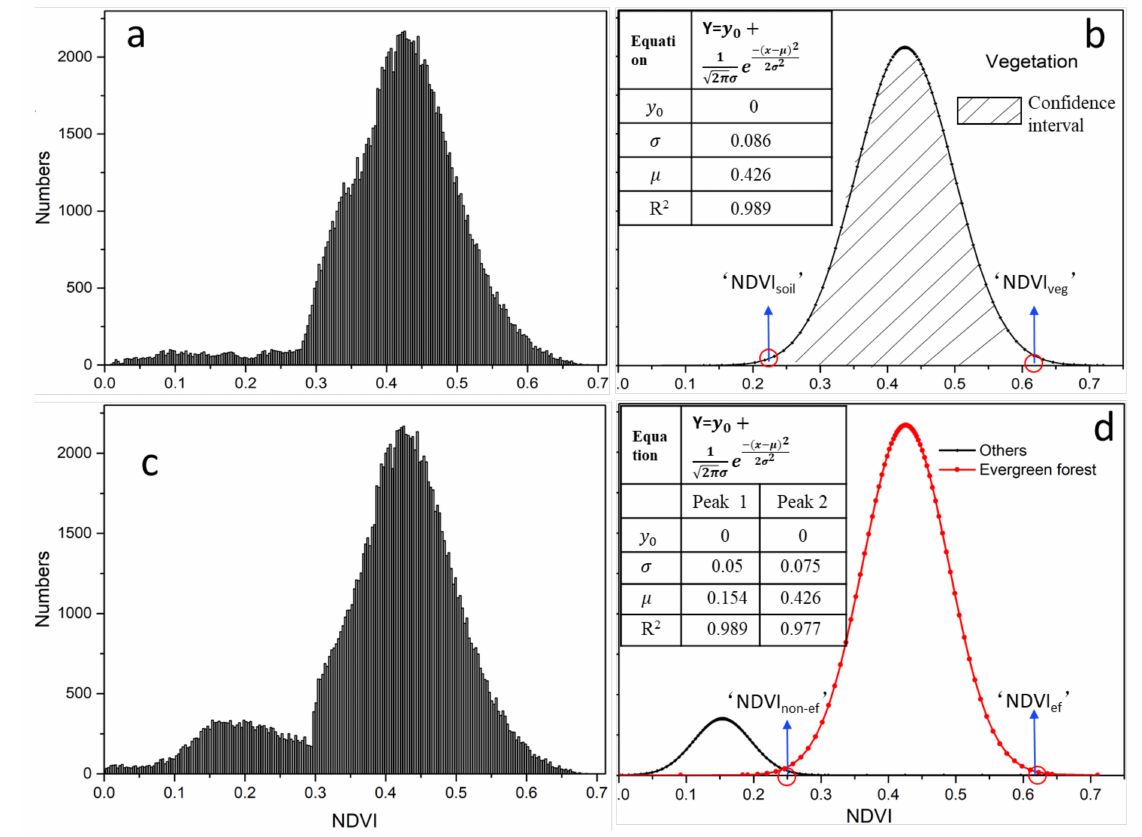
Figure 2. Gray level histograms of NDVI in single-value and binary space. ( b ) Curve fitting the NDVI frequency histogram shown in ( a ). The parameters and R 2 of the fitted Gaussian function are listed in Table in ( b , d ). ( d ) Bimodal curve fitting of the NDVI frequency histogram in shown in ( c ). Peak 1 is the Gaussian curve of the background (non-evergreen forest); Peak 2 is the Gaussian curve for object (evergreen